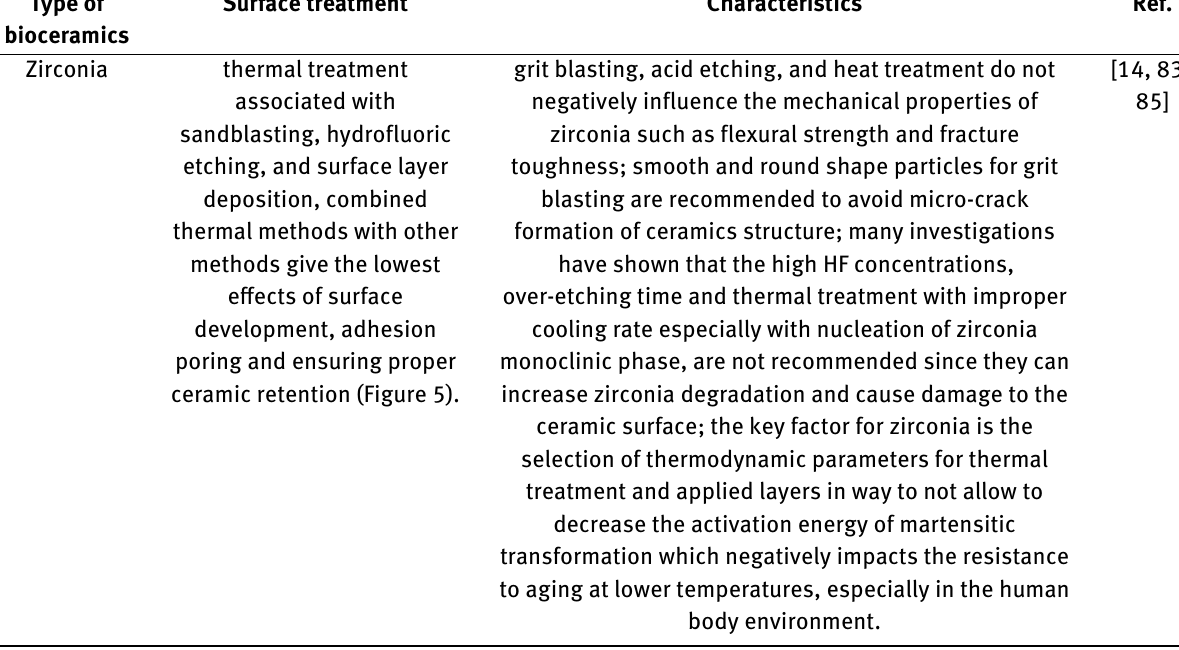
Table 7: Influence of thermal treatment for bioceramic surface modification Type of Surface treatment Characteristics bioceramics